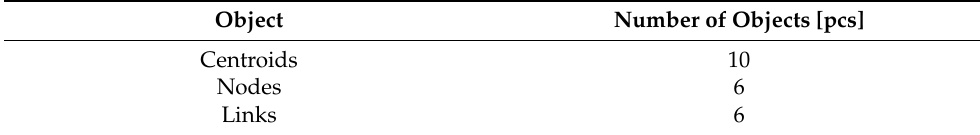
Table 7. Input data for road network creation (source elaborated by authors).